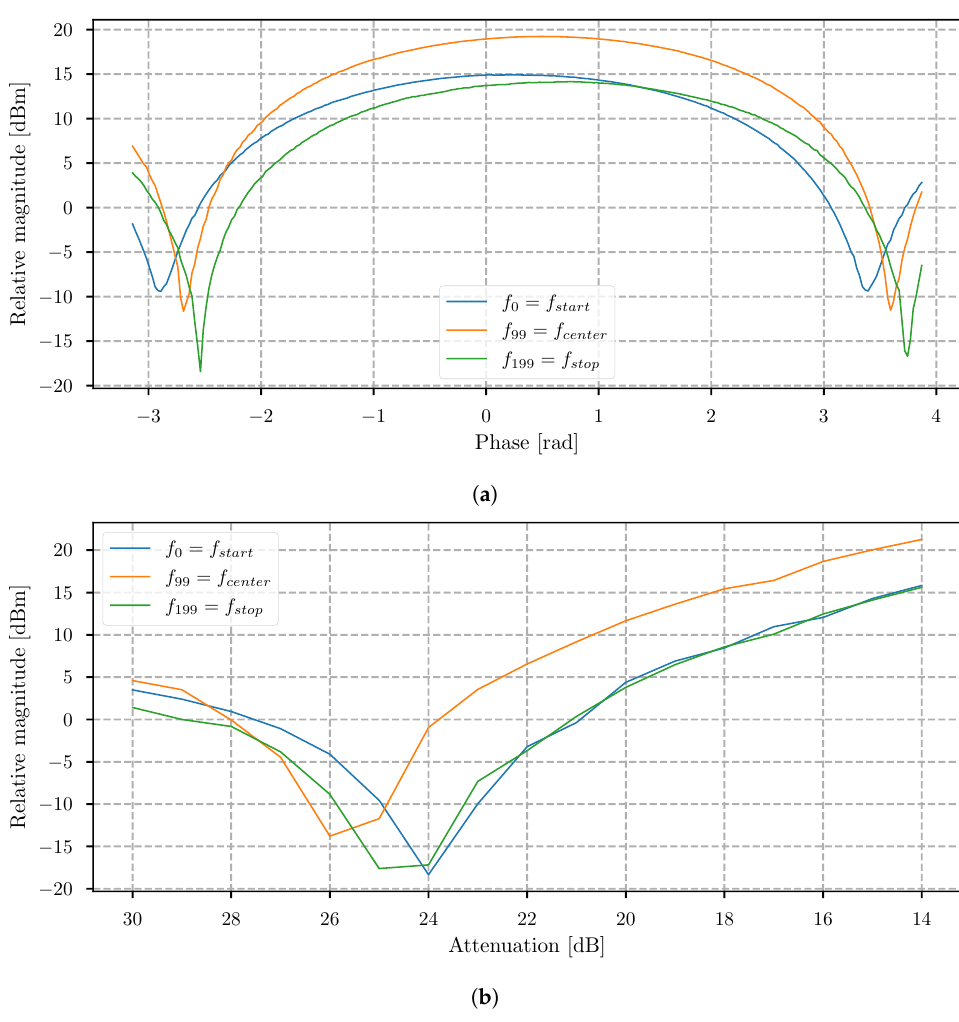
s iq , n of the summed EC and RX signal for frequencies f start , f center , | |